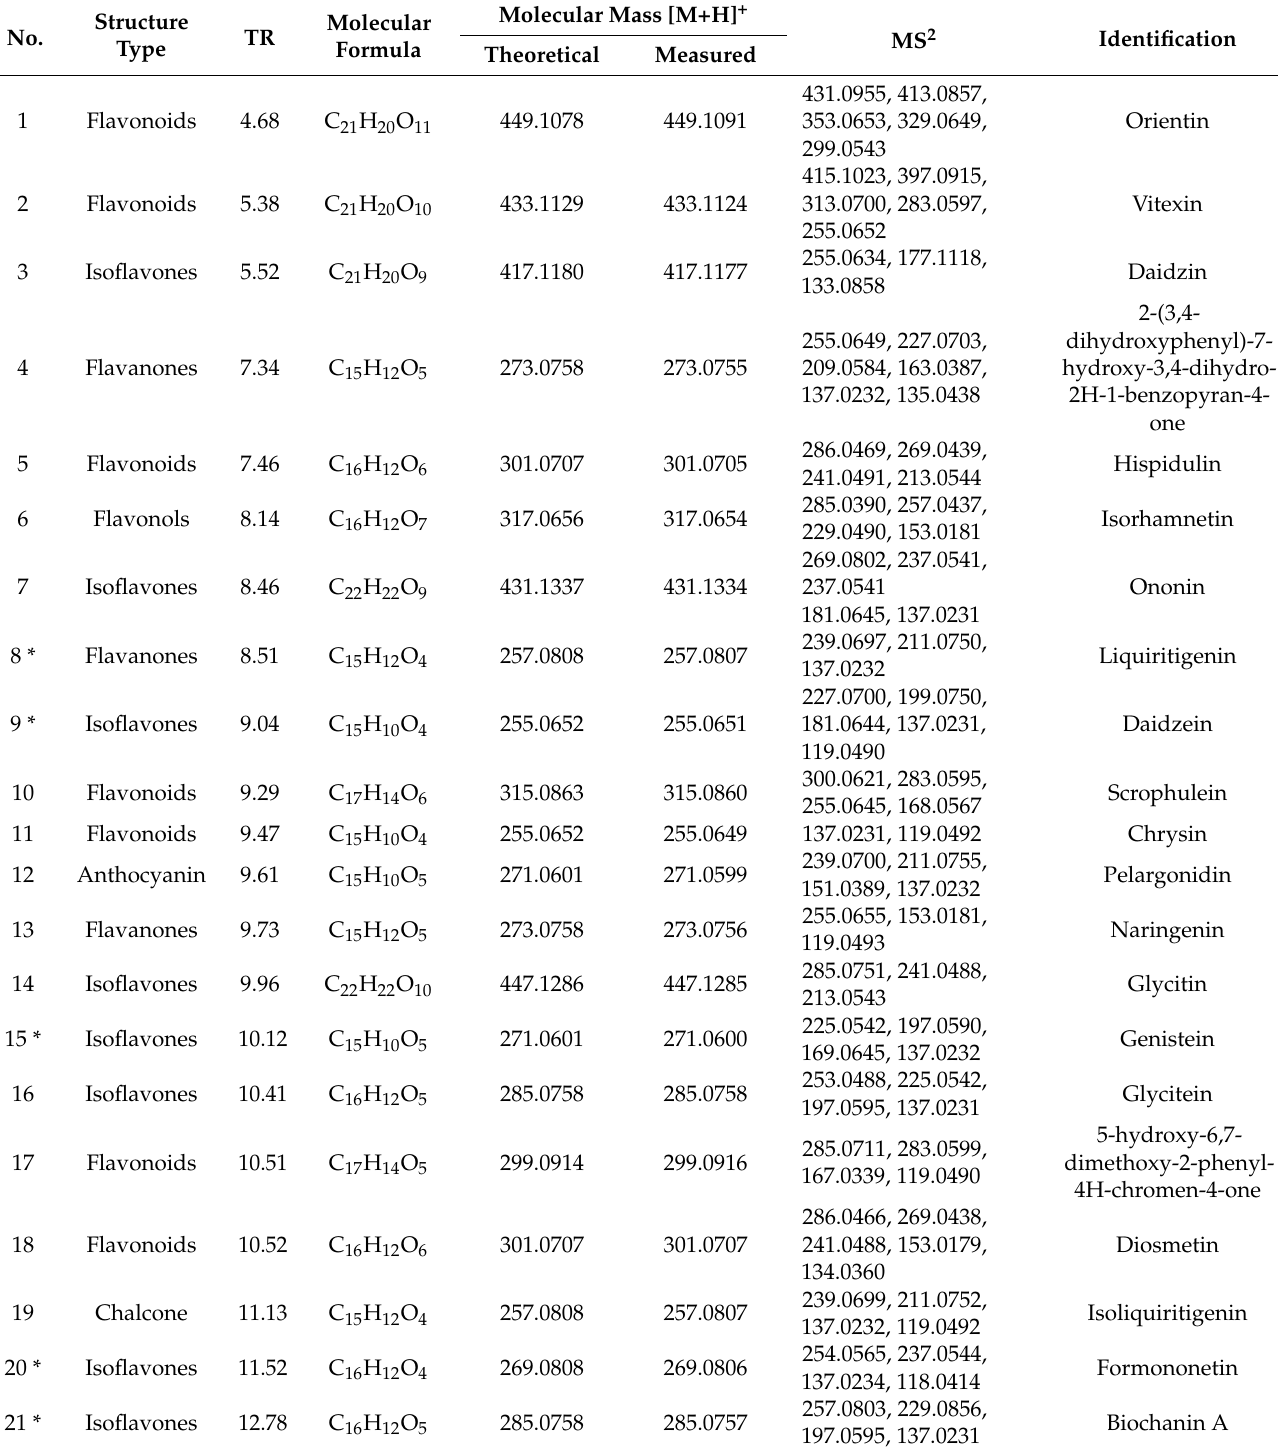
Table 2. Pigment components of D. oliveri extract analyzed by